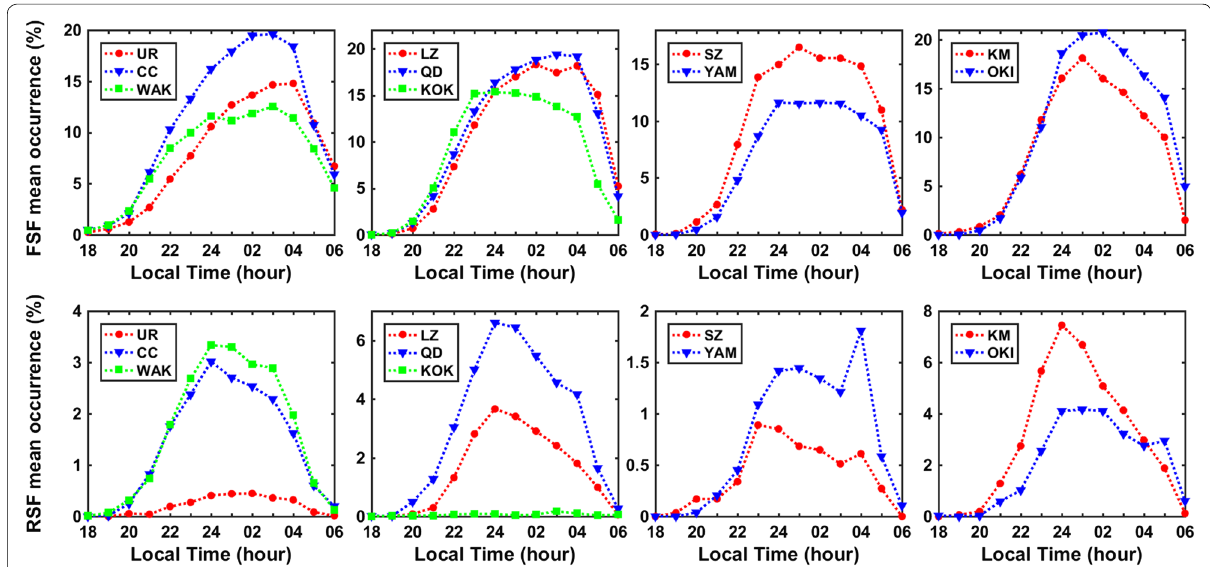
Fig. 12 Nocturnal variations in FSF and RSF mean occurrence percentages; the x -axis is the local time and the y -axis is the FSF or RSF mean